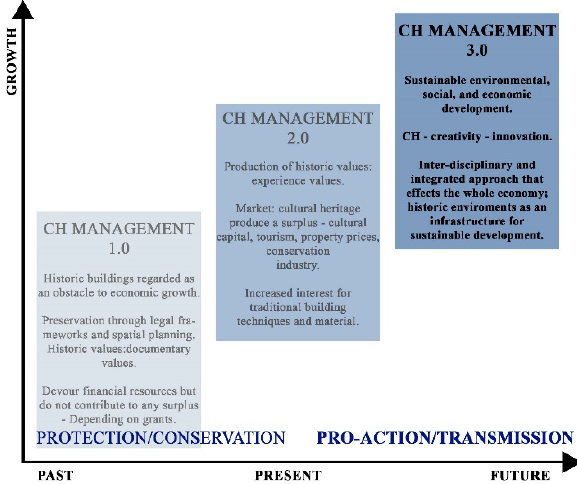
Figure 1: The evolution of Cultural Heritage’s management models: the vision passes from protection/conservation to pro- action/transmission in CH 3.0 (Gustafsson, 2015).